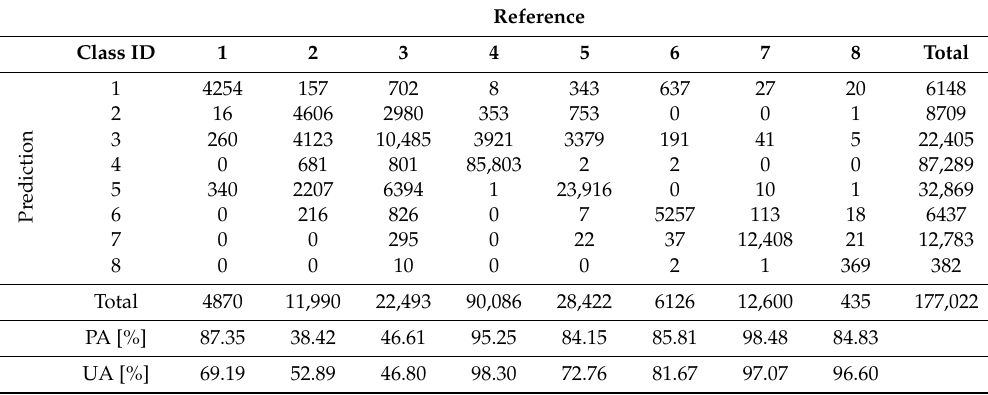
Table A7. Confusion matrix after the 10-fold LLOCV using MC rule and 5 × 5 neighborhood for aggregation (Legend for Class ID: 1 Ostryo-Carpinion, 2 Quercion frainetto, 3 Quercion